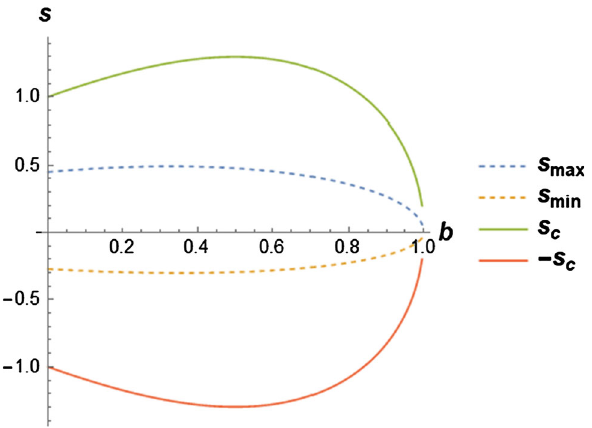
Fig. 2 The maximal and minimum value of spin s of the particles in the extreme case for different values of b as well as its comparison with s